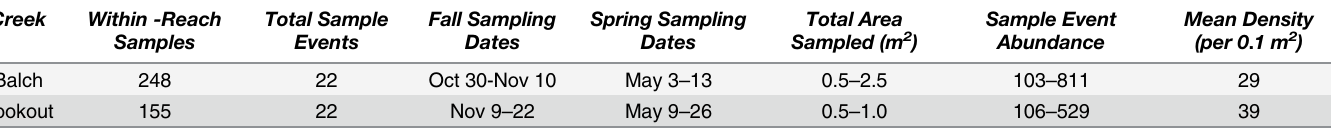
Table 2. Summary of long-term invertebrate data collected by participants from 2005 – 2015. Annual sampling did not occur on the same day each year, so the range of sampling days over the 11-year study period is shown as fall and spring Sampling dates. Total area sampled is the combined area sam- pled by all groups during each sampling event. Sample event abundance is the total number of invertebrates collected during each sampling event. Mean density is expressed as number of invertebrates per 0.1 m 2